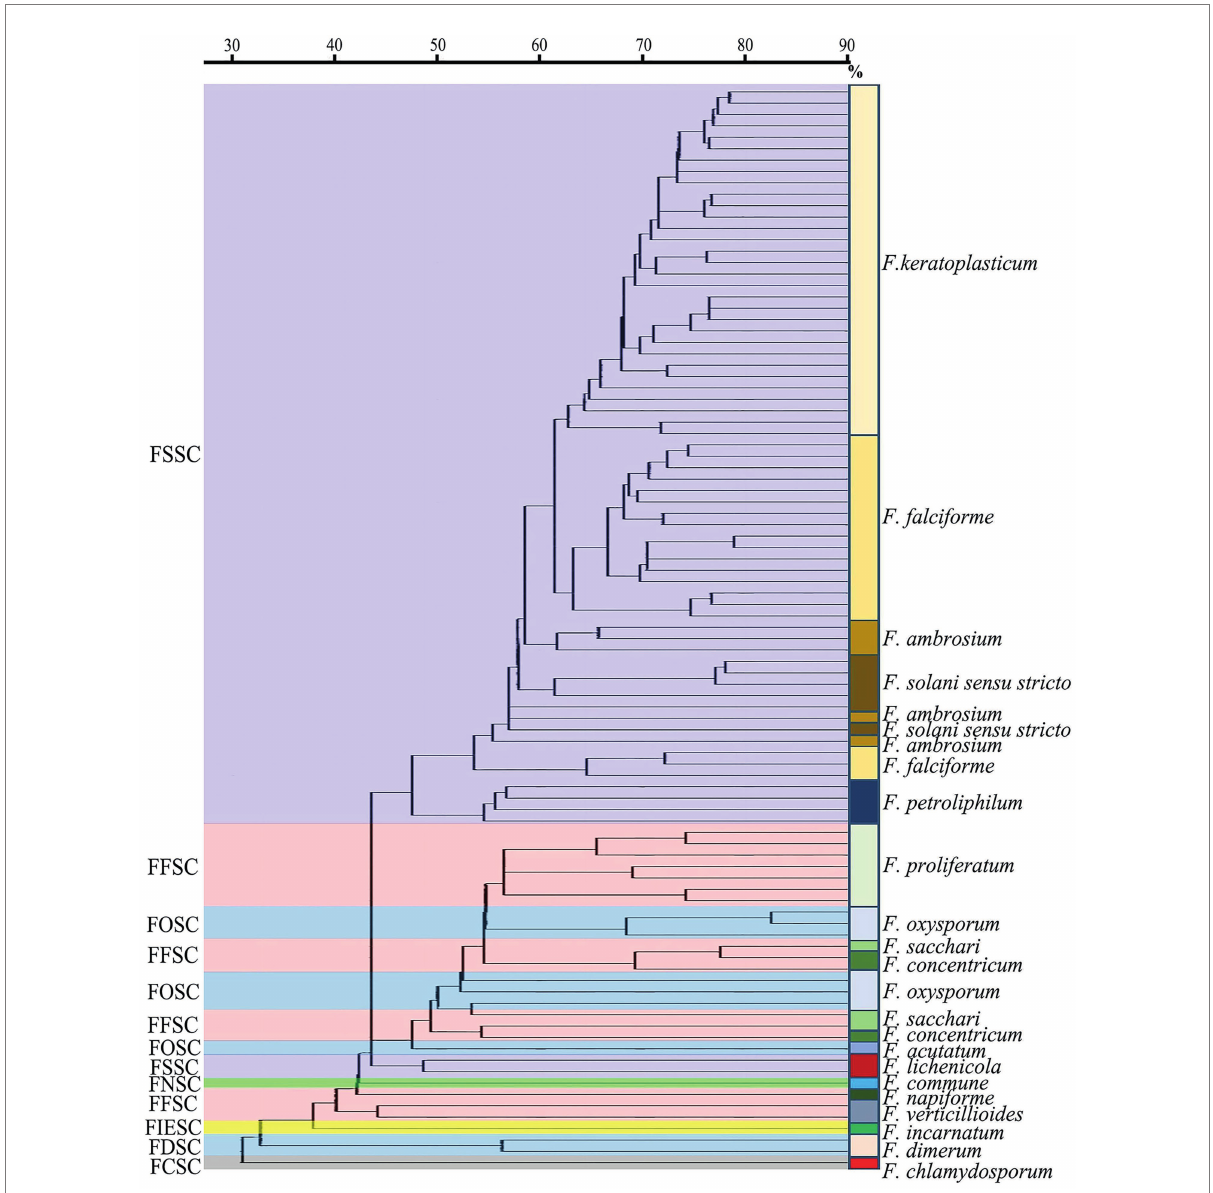
FIGURE 3 The MALDI-ToF dendrogram of 95 clinical Fusarium strains. FSSC, F. solani species complex (SC); FFSC, F. fujikuroi SC; FOSC, F. oxysporum SC; FNSC, F. nisikadoi SC; FIESC, F. incarnatum-equiseti SC; FDSC, F. dimerum SC; FCSC, F. chlamydosporum